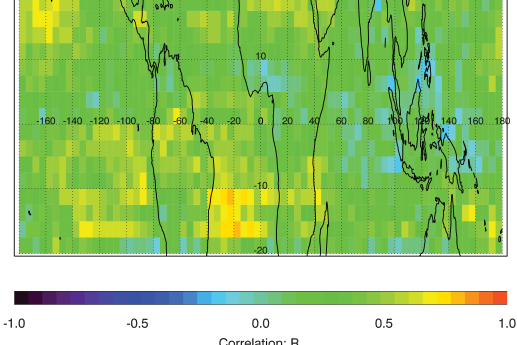
Figure 16. (a) Mean bias between CCD and LNM for the years 2003 until 2011. (b) Correlation ( R ) between CCD and LNM SCIA- MACHY tropospheric ozone for the years 2003 until